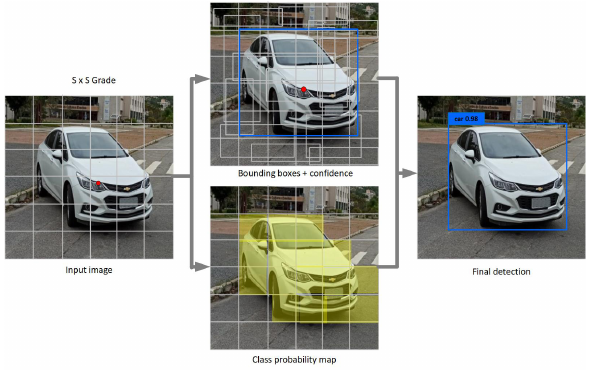
Figure 4. The detection principle of the YOLO model.